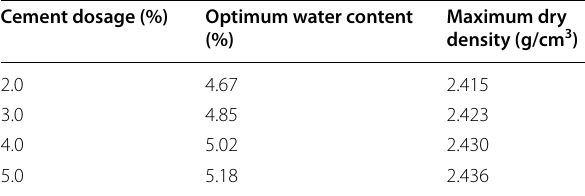
Table 2 Standard compaction test results of the CSM with different cement